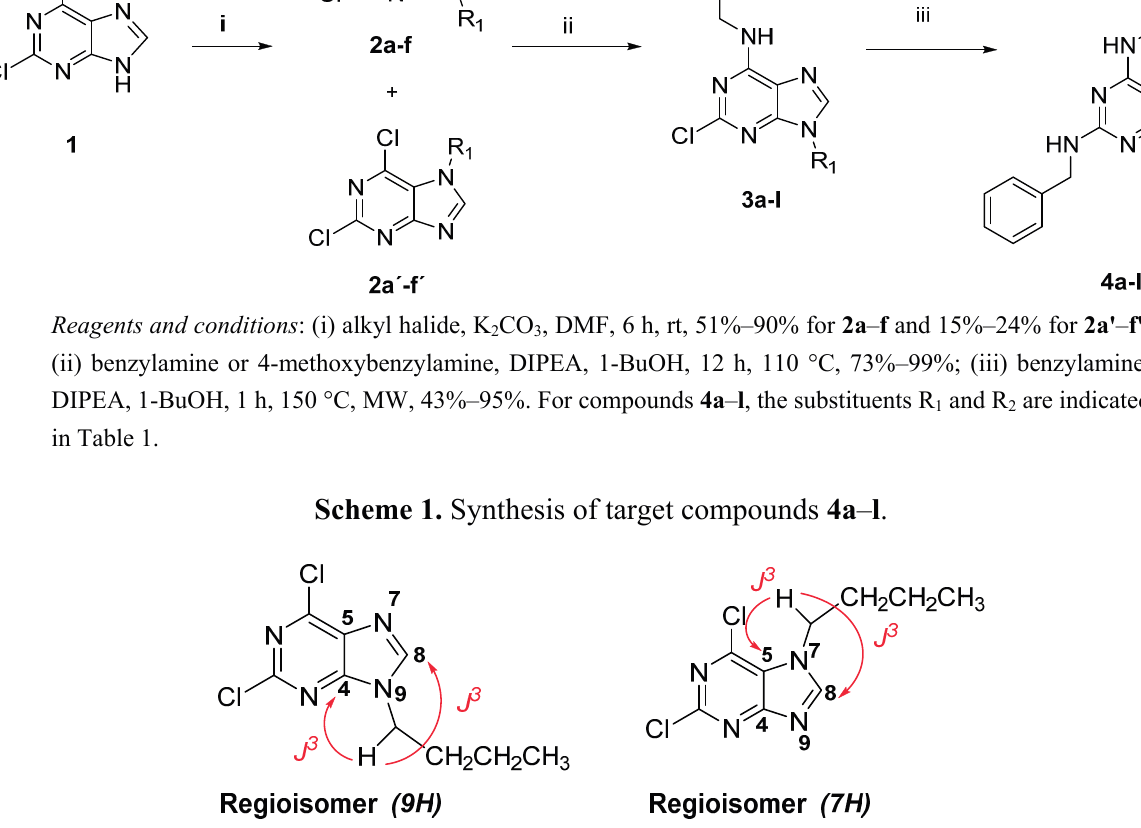
Figure 2. Structures of compounds 2b and 2b' and key HMBC